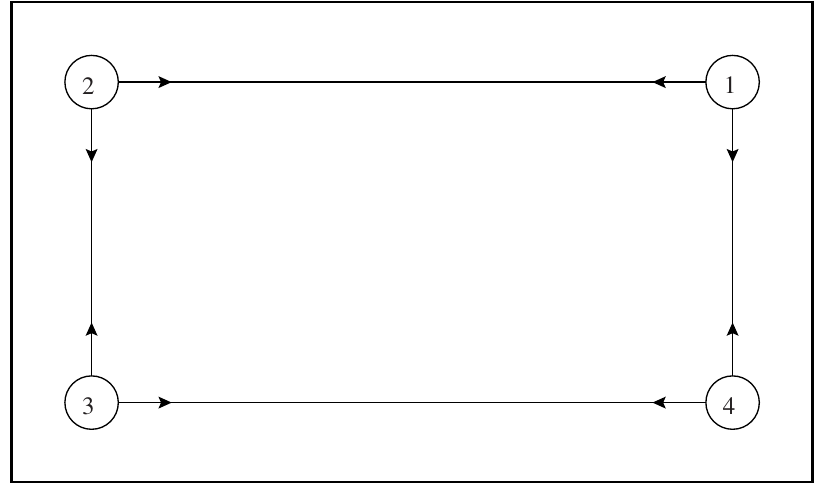
Figure 10. Pursuer-evader games: the evader strategy implemented in Algorithm 1.